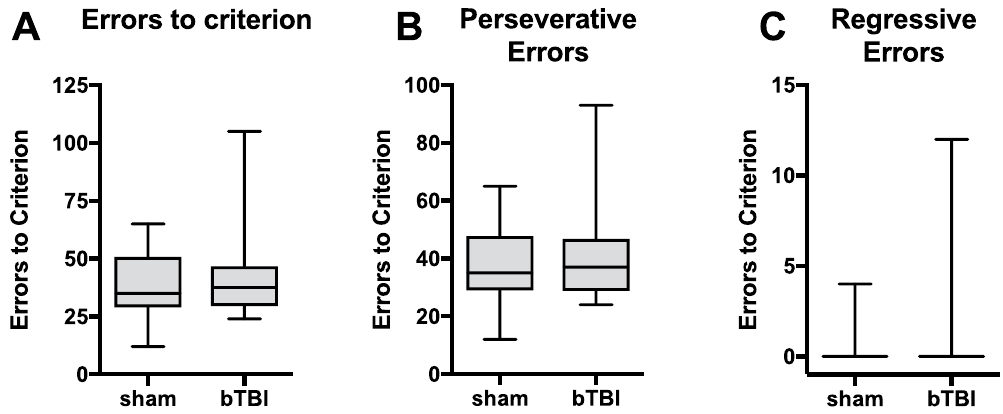
Figure 4. Performance in reversal of response discrimination. ( A ) Number of errors committed during acquisition of reversal. ( B , C ) Analysis of error type during acquisition of reversal: ( B ) Perseverative errors, ( C ) Regressive errors. Boxes represent median and quartiles, whiskers represent range. N = 12/group.